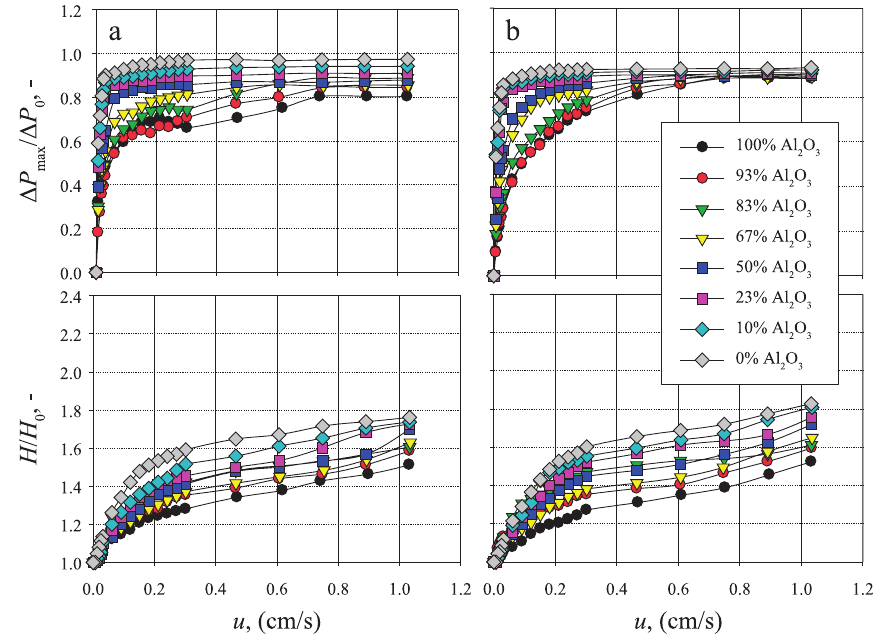
Fig. 5 Dimensionless pressure drop (Δ P /Δ P 0 ) and bed expansion ( H / H 0 ) as functions of superficial gas velocity during aeration for binary mixtures of Al 2 O 3 and Fe 2 O 3 . (a) 130 dB–120 Hz; (b) 135 dB–120 Hz.